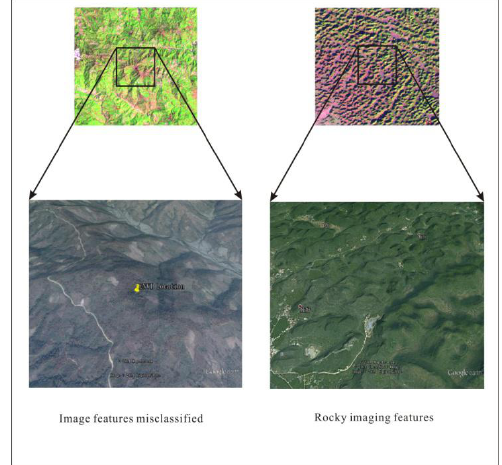
Figure 6. Google Earth corresponding image